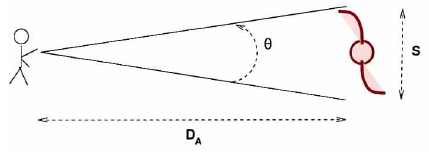
Figure 14. Angular diameter